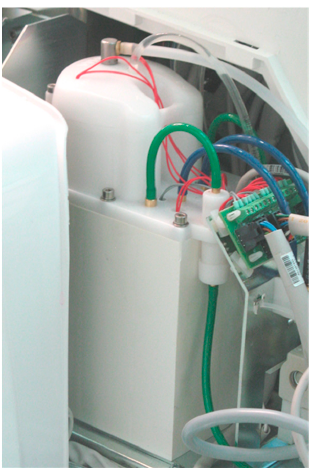
Figure 1. The Water Hygienization Equipment (W.H.E.) device inside a dental unit, at the inlet of the municipal water.